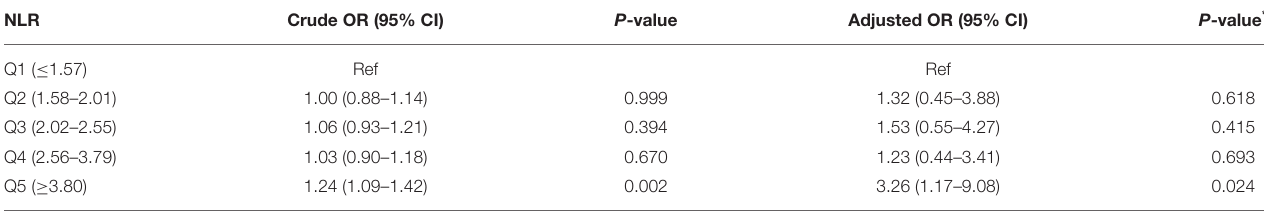
TABLE 4 | Multivariable analysis for PSCI according to the quintiles of NLR.